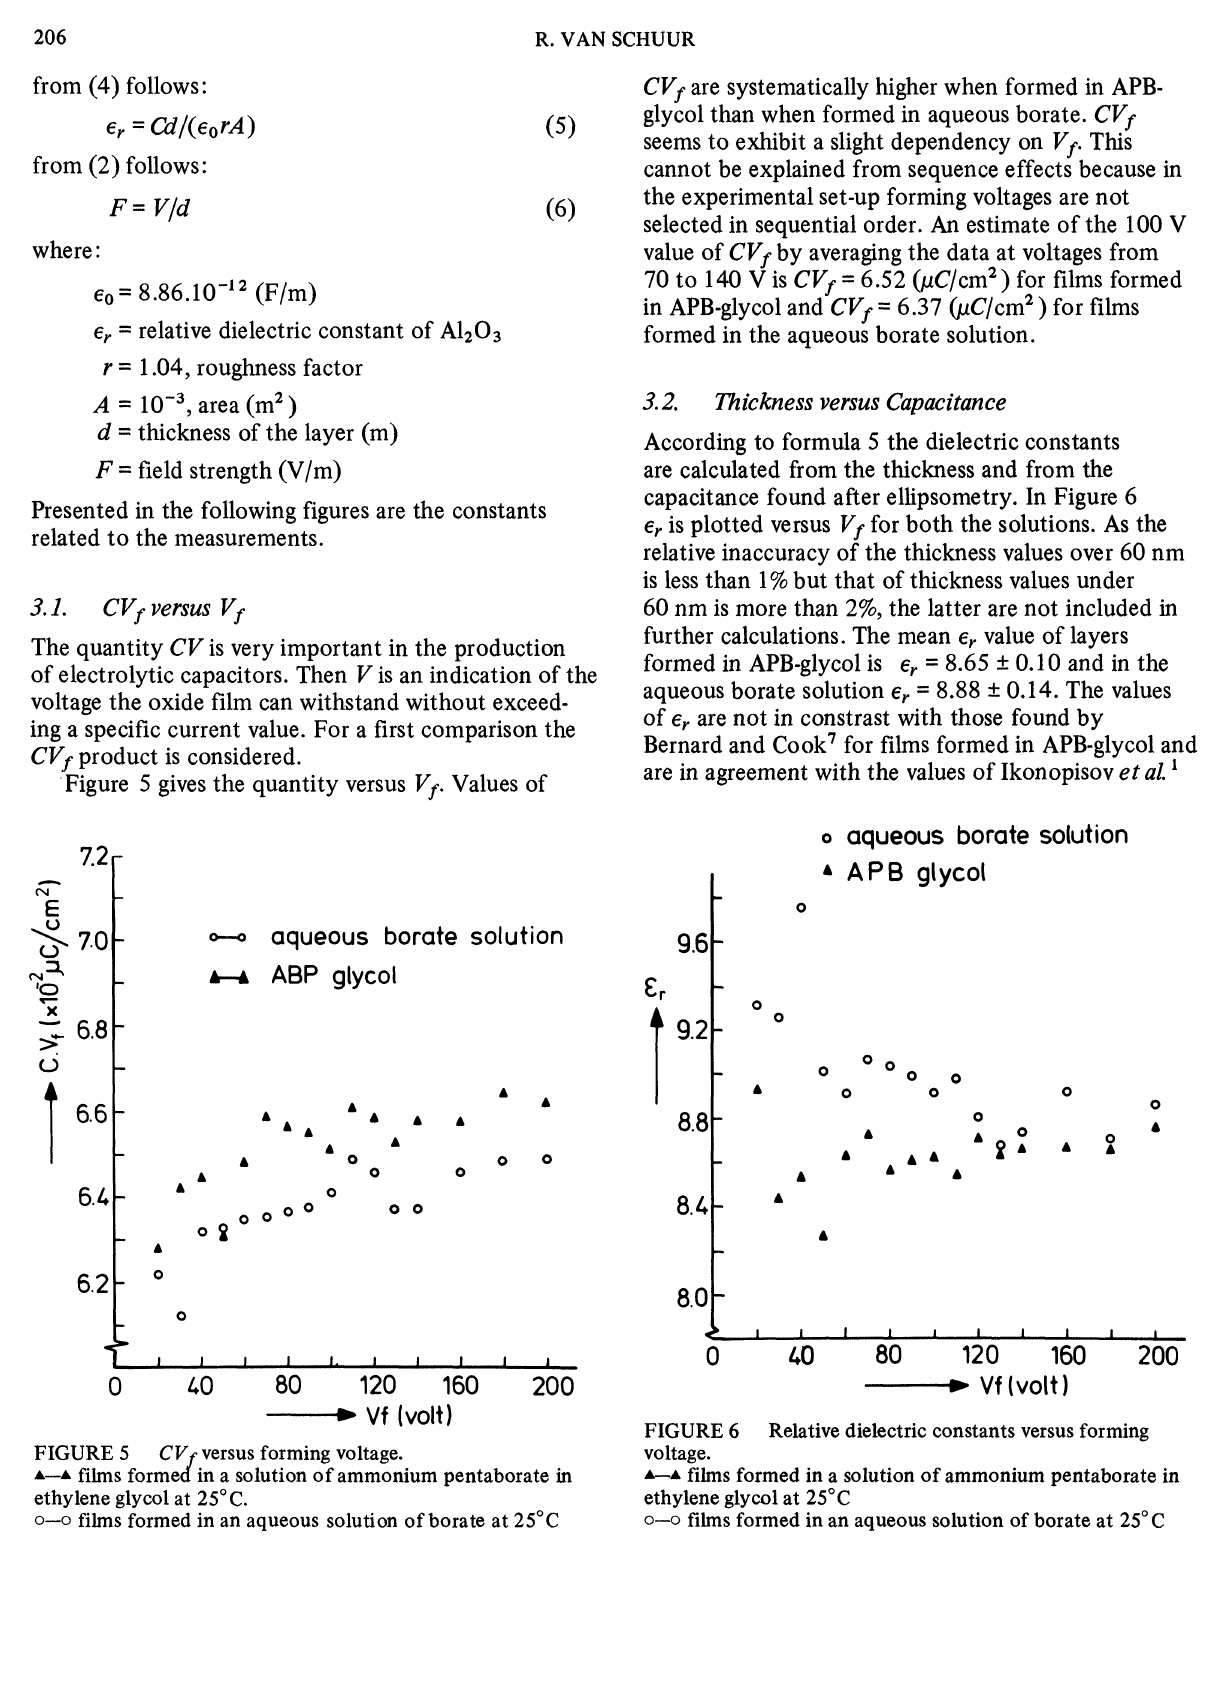
CVf versus forming voltage. A--A films formedin a solution of ammonium pentaborate in ethylene glycol at 25 C. o--o films formed in an aqueous solution ofborate at 25C